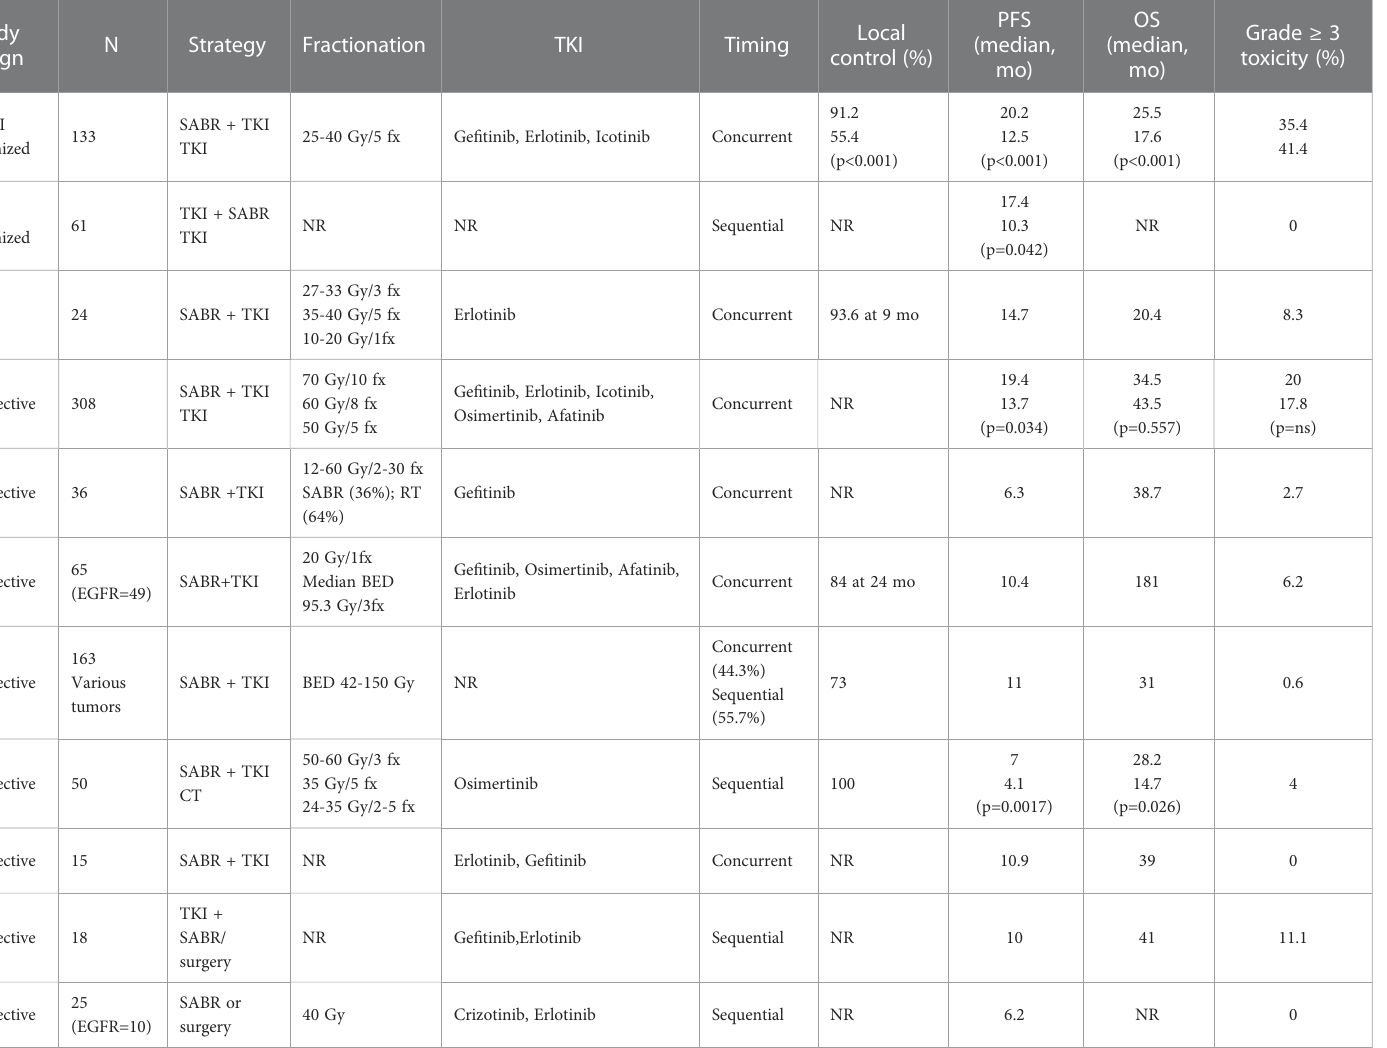
TABLE 1 Selected studies of SABR and TKIs combination in metastatic NSCLC EGFR-mutated